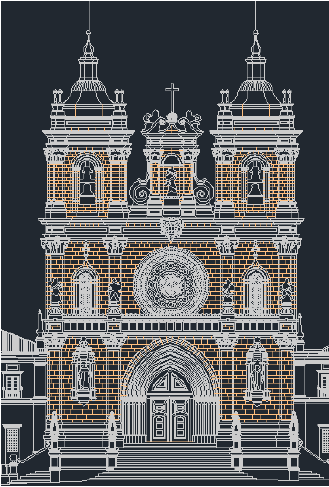
Figure 15. Dense cloud-point reconstruction of the facade of the church of Alcobaça monastery (Coelho, Genin, 2016).